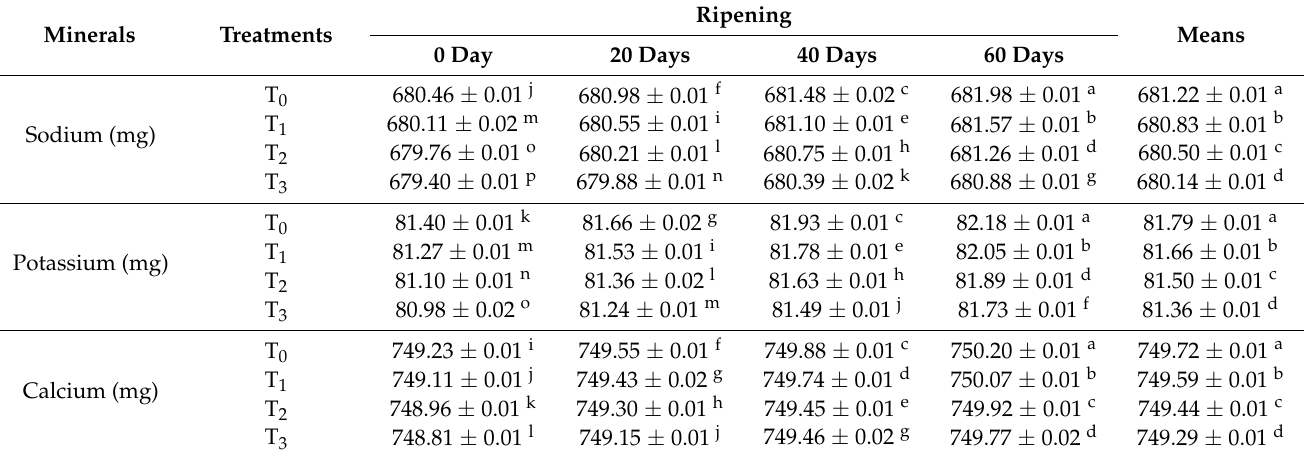
Table 2. Mineral profile of all cheese treatments during the ripening period (means ±